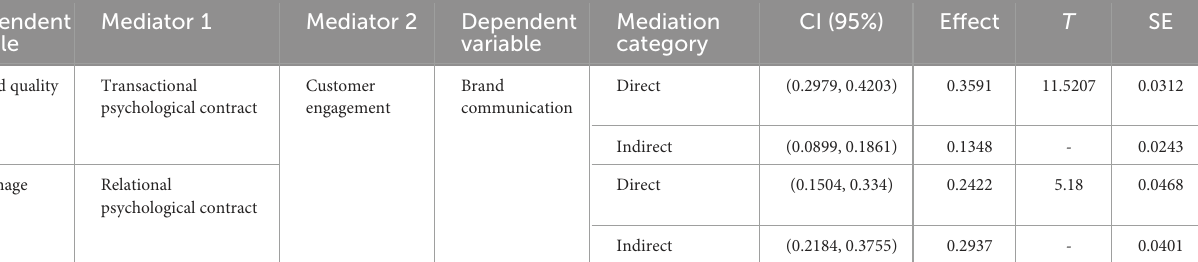
TABLE 6 The chain mediation effect testing based on Bootstrap.